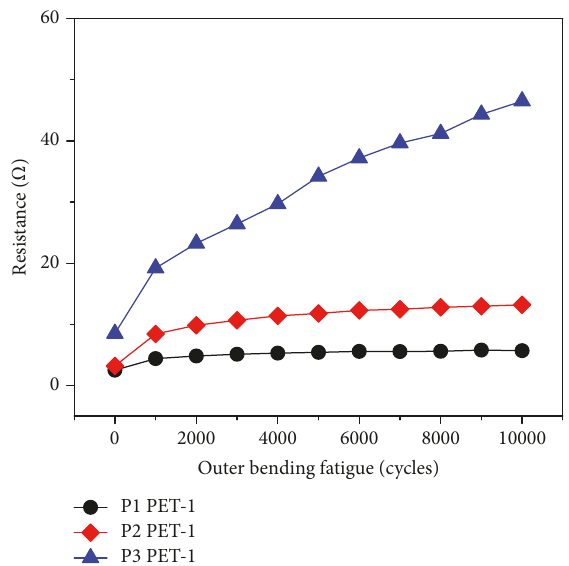
Figure 11: Electrical resistance versus bending cycle plot for outer bending fatigue test.